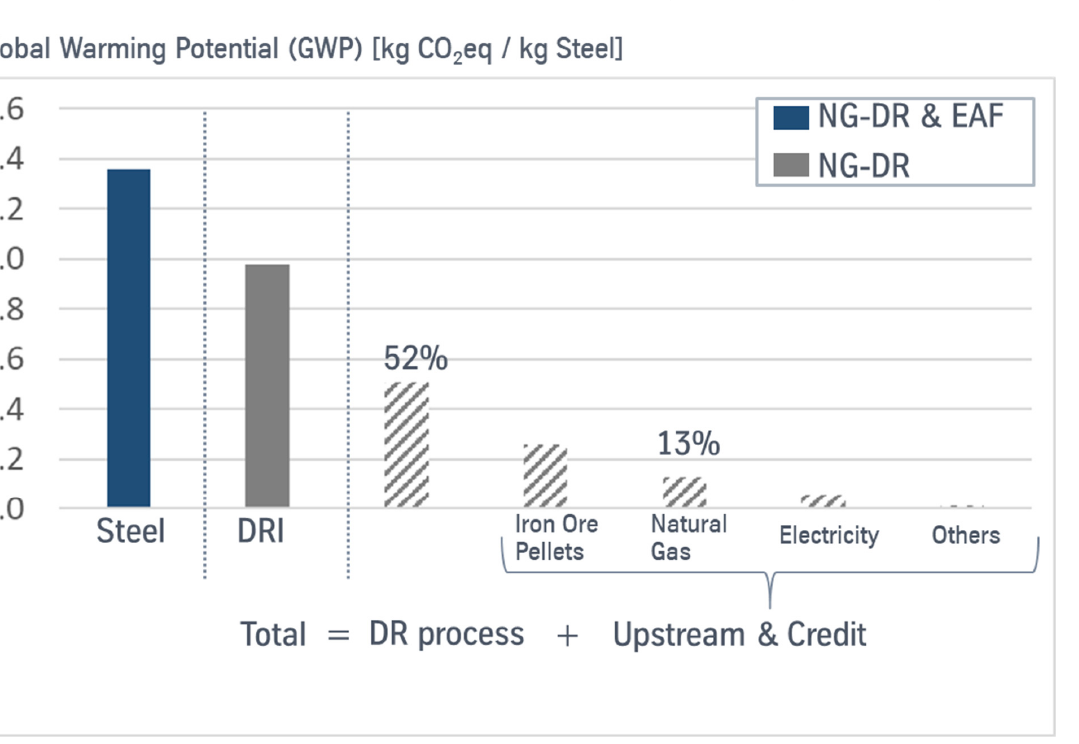
Figure 7. Carbon footprint of steel and impact of natural gas (NG)-based direct reduced iron (DRI) production.